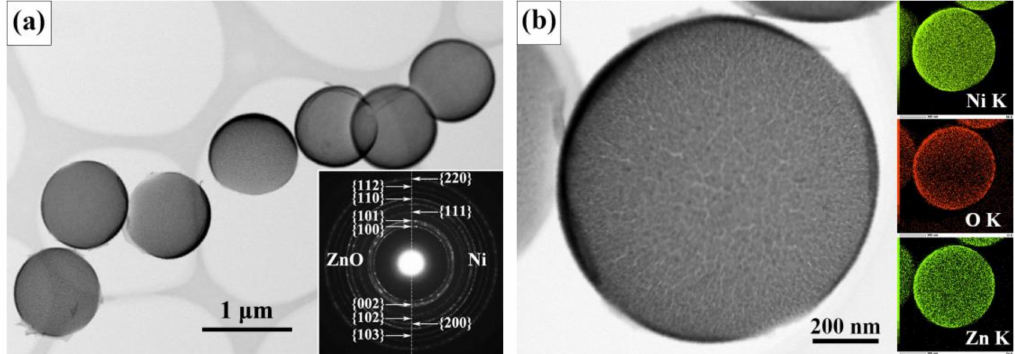
Figure 2. TEM results of ZnO / Ni hollow microspheres, ( a ) the low-magnification image and the corresponding SAED pattern, ( b ) the image of a single microsphere and the corresponding EDS mapping of Zn, O, and Ni